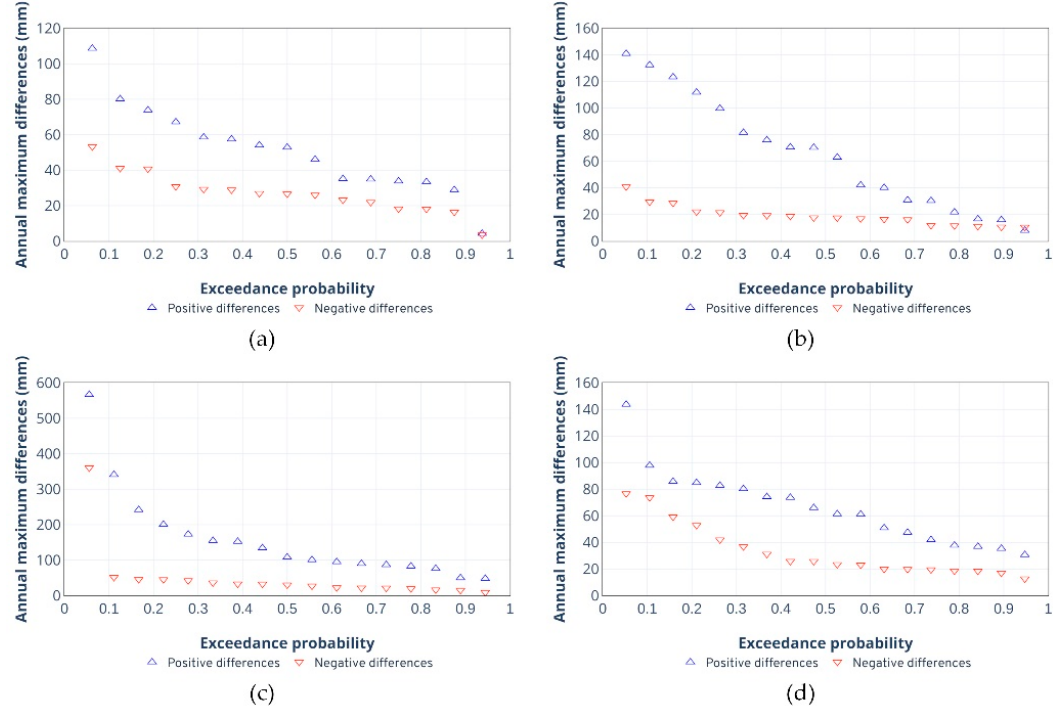
Figure 7. Results of the maximum annual differences between the precipitation estimated by the CMORPH algorithm and the precipitation observed in the station, for some of the analyzed stations. Accumulated precipitation in 24 h: ( a ) Station 5; ( b ) Station 11; ( c ) Station 12; ( d ) Station 14.